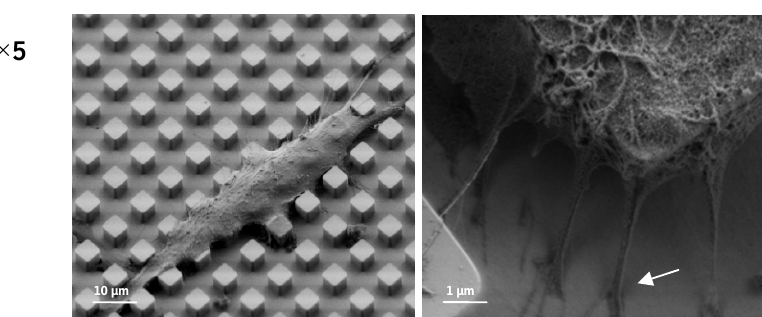
Figure 4. ( a ) Cell area of membrane stained MG-63 cells after 24 h. Cells grown on